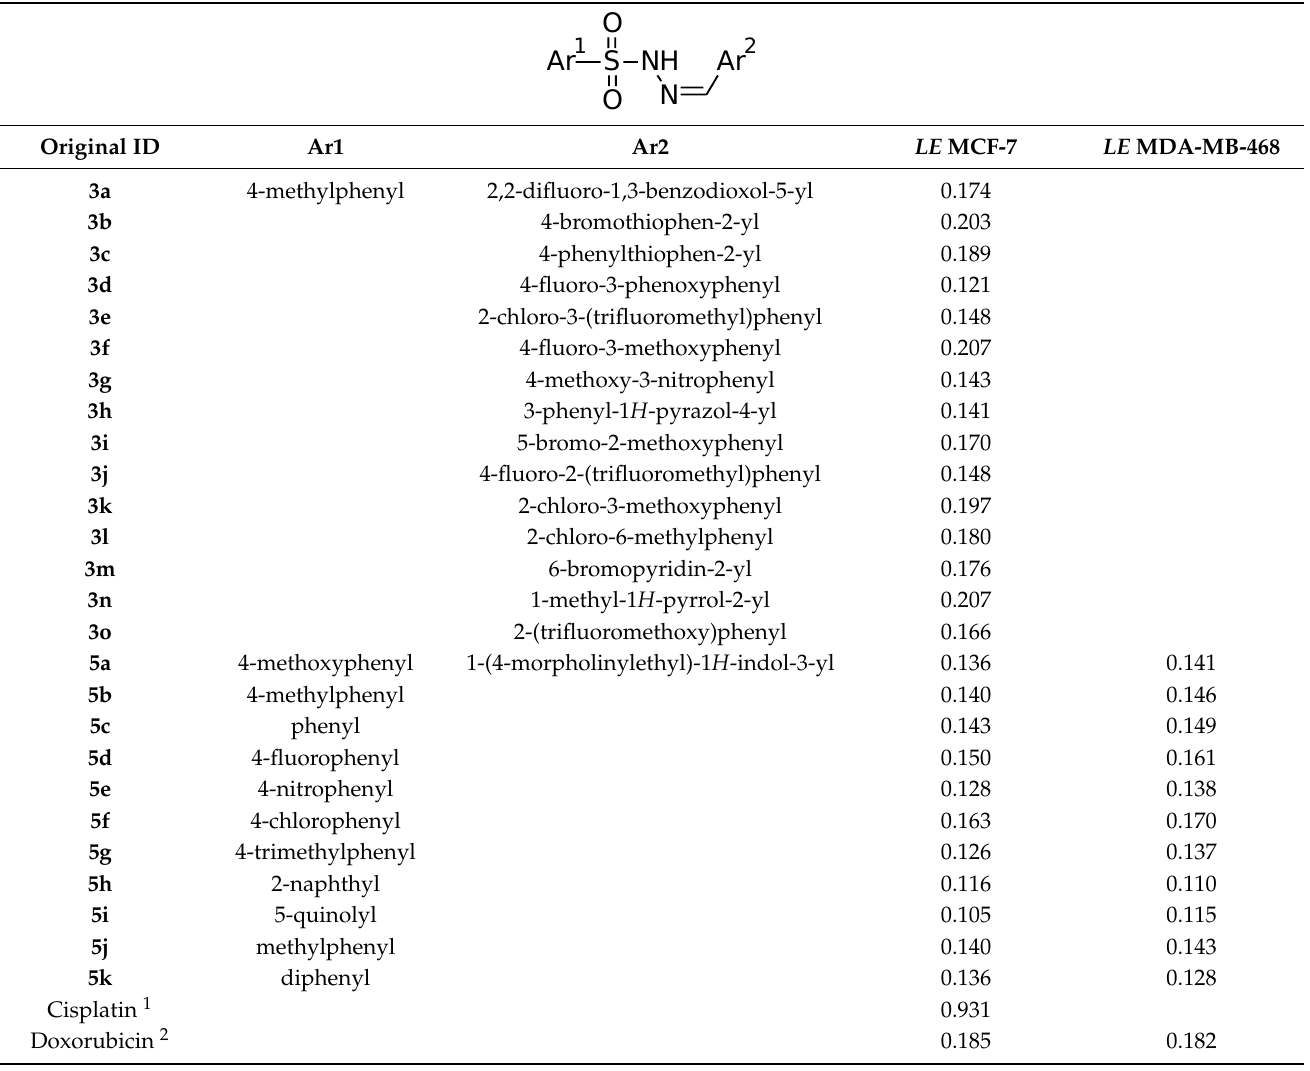
Table 1. Training set used in the study for the derivation of QSAR models. Compounds 3a – o are collected from Senkardes et al. [12], and compounds 5a – k —from Gaur et al. [13]. LE stands for Ligand Efficiency. The anticancer activities of the compounds are measured on human breast adenocarcinoma cell line MCF-7 ( n = 26) and on the TNBC cell line MDA-MB-468 ( n = 11).